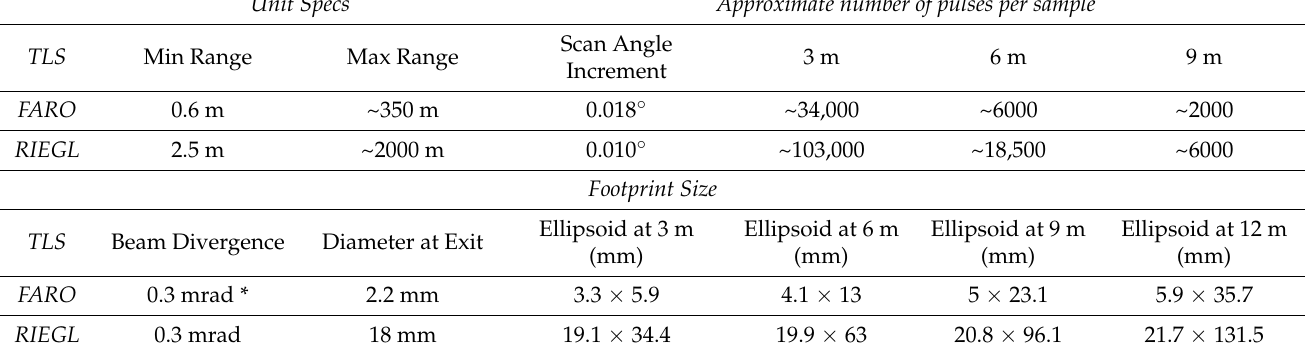
Table 3. Summaries of the two TLS units used for this study. Scan time was ~3.5 min with both scanners running simultaneously using 1550 nm wavelength laser light for each unit. Laser pulses intercepted the samples at differing angles for each distance. The footprint ellipsoid was significantly elongated at the further